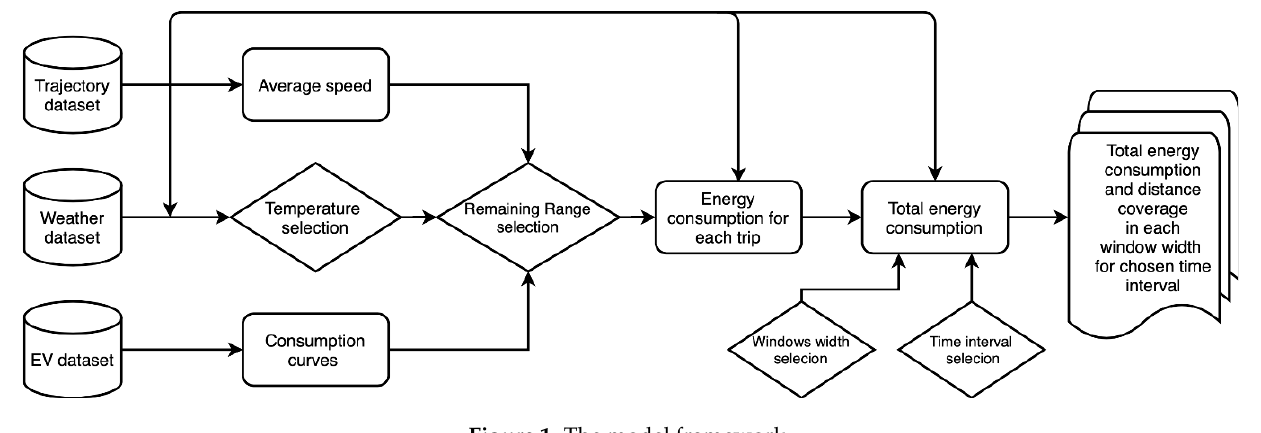
Figure 1. The model framework.